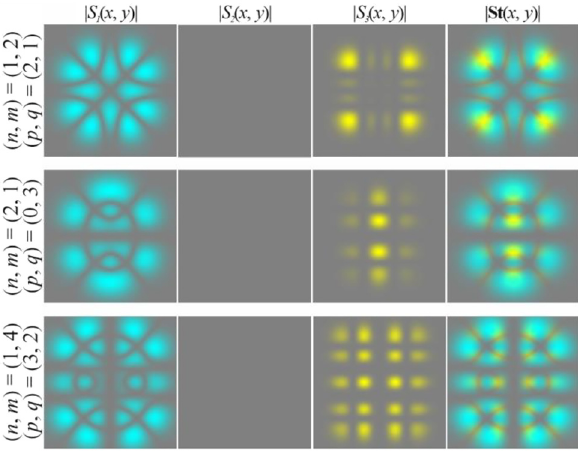
Figure 5: Distribution of the Stokes vector defined by Eq. (24) for inhomogeneously polarized beams de fi ned by Eq. (27) presented in Figure 4.